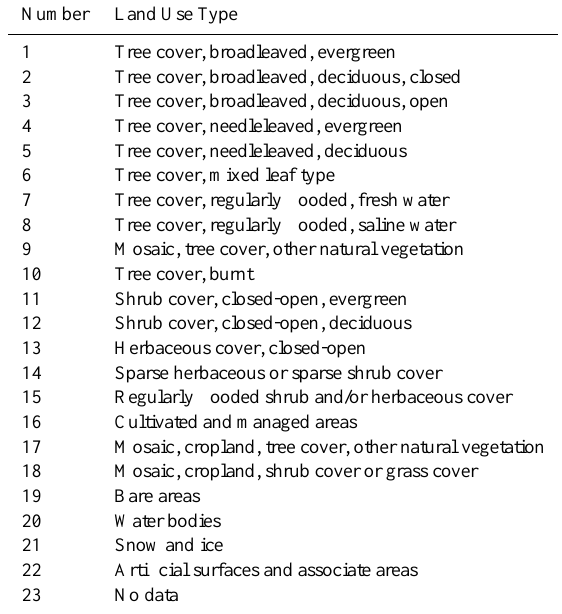
Table 2. The land-use land cover classes in Bartholome at al. (2002) and Fritz et al.